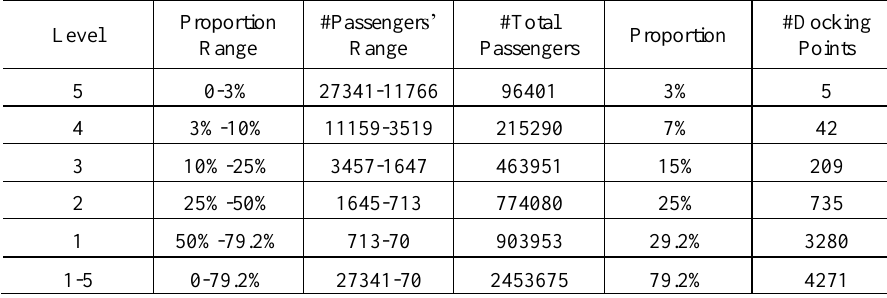
Table 2. Extraction results of drop-off docking points